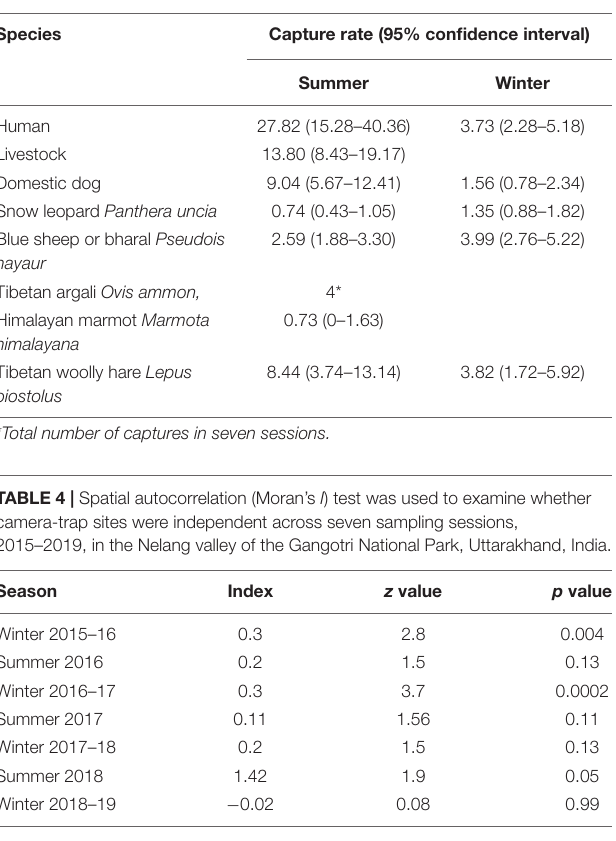
TABLE 3 | Seasonal capture rate (#/100 trap nights) of humans, livestock, dogs, snow leopard, and potential prey species of the woolly wolf in the Nelang valley of the Gangotri National Park, Uttarakhand, India.